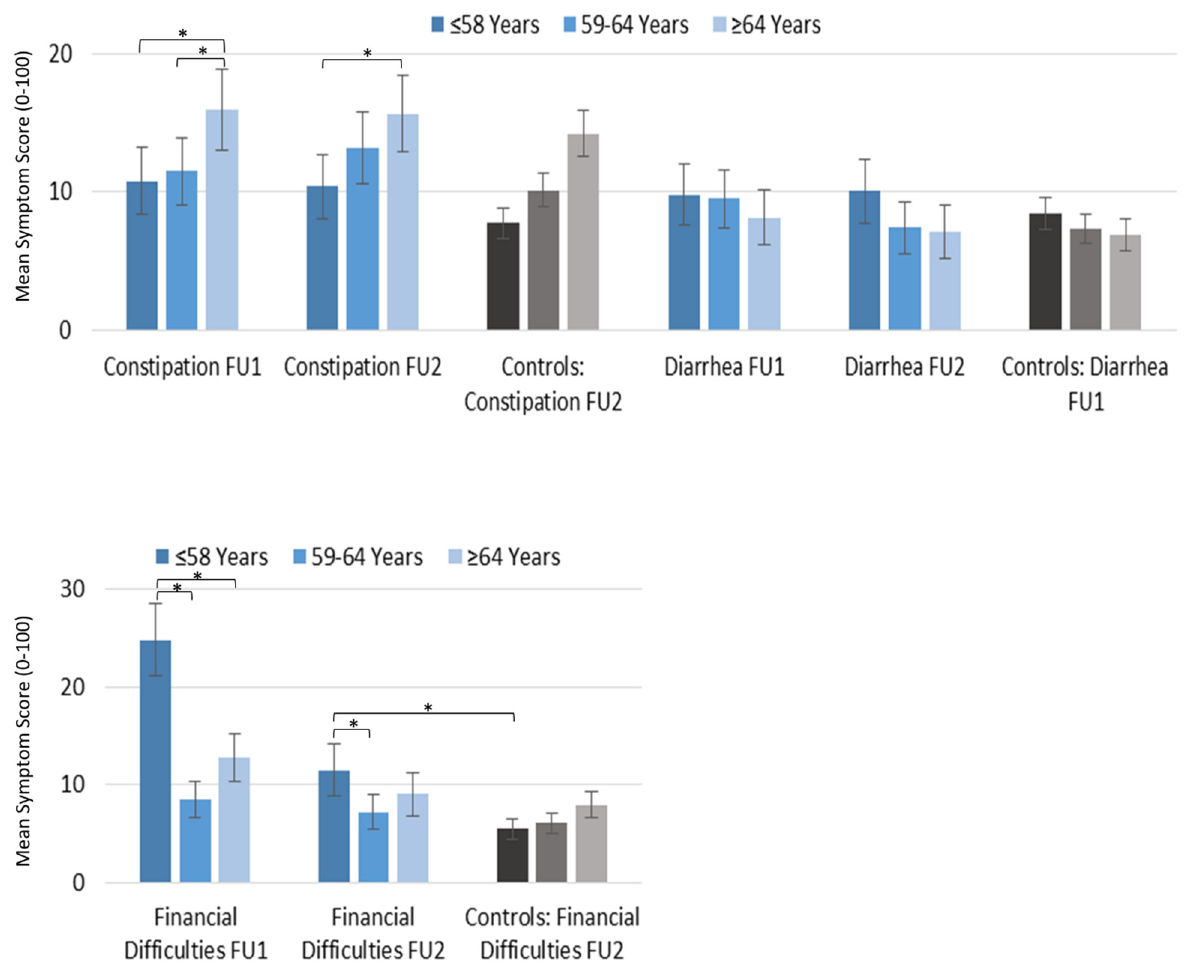
Figure 4. Symptoms in breast cancer survivors at FU1 and FU2 stratified by age and compared to controls. Significant differences are indicated by an asterisk.